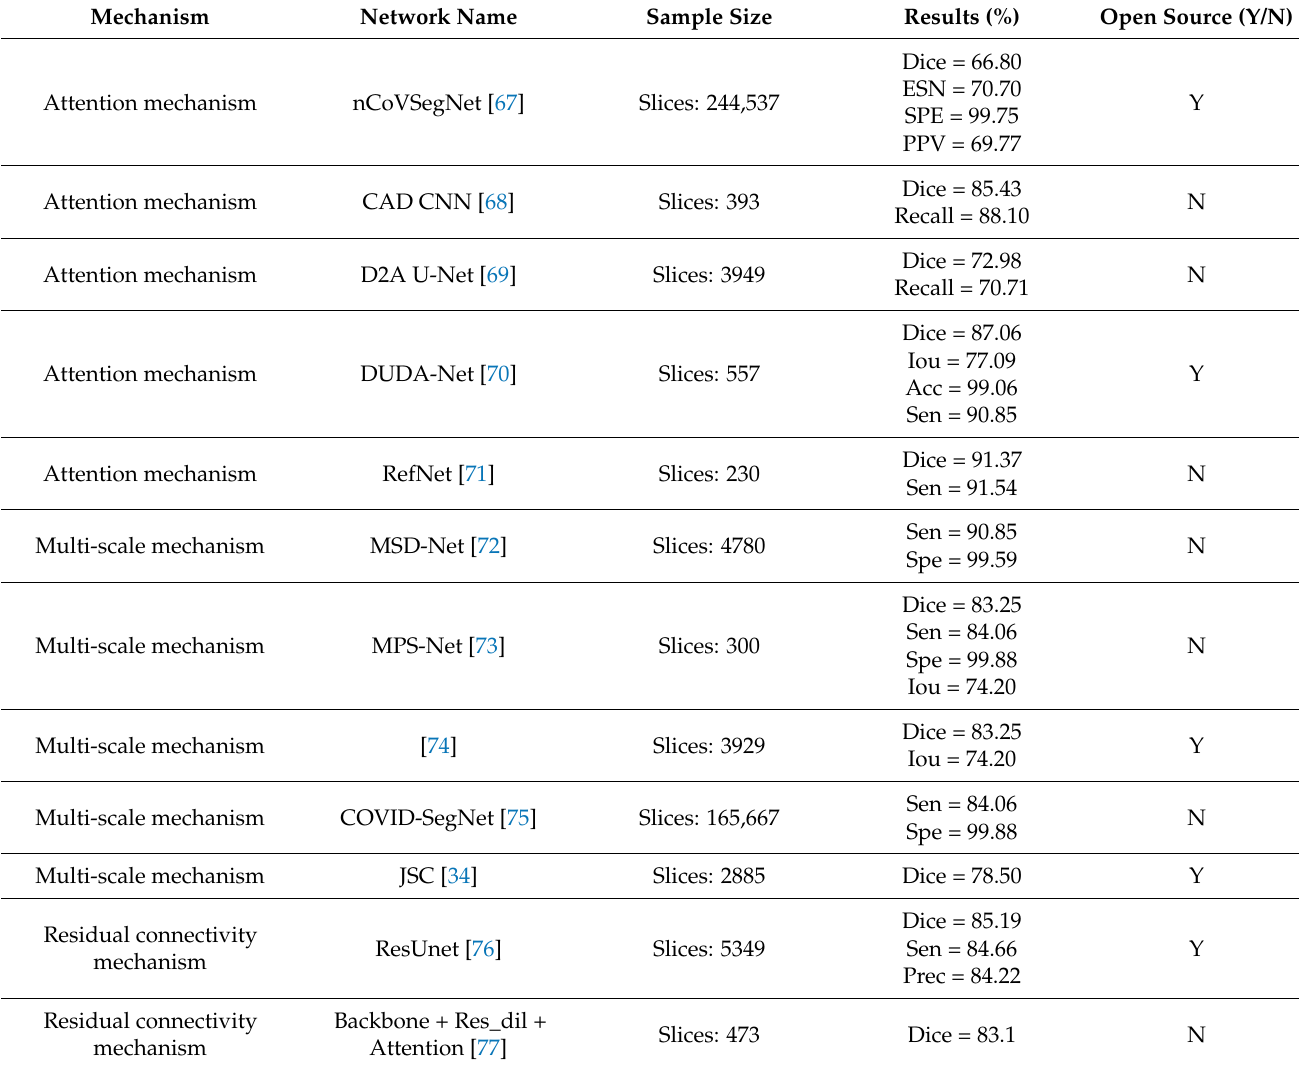
Table 3. COVID-19 segmentation methods based on supervised